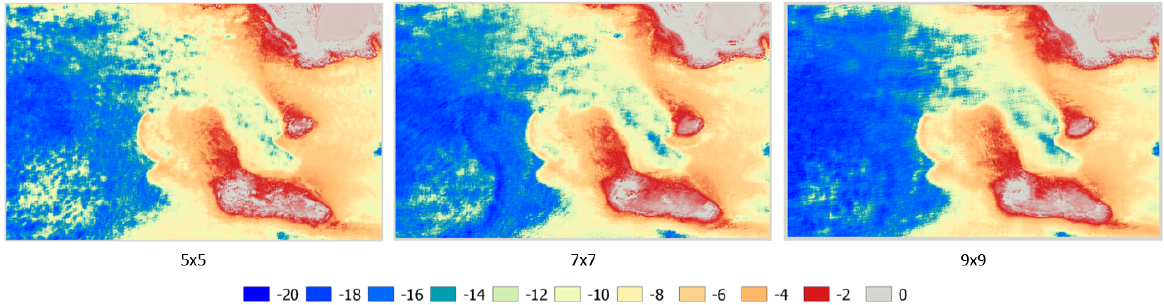
Figure 5. Visualization of SDB result generated with different window sizes.